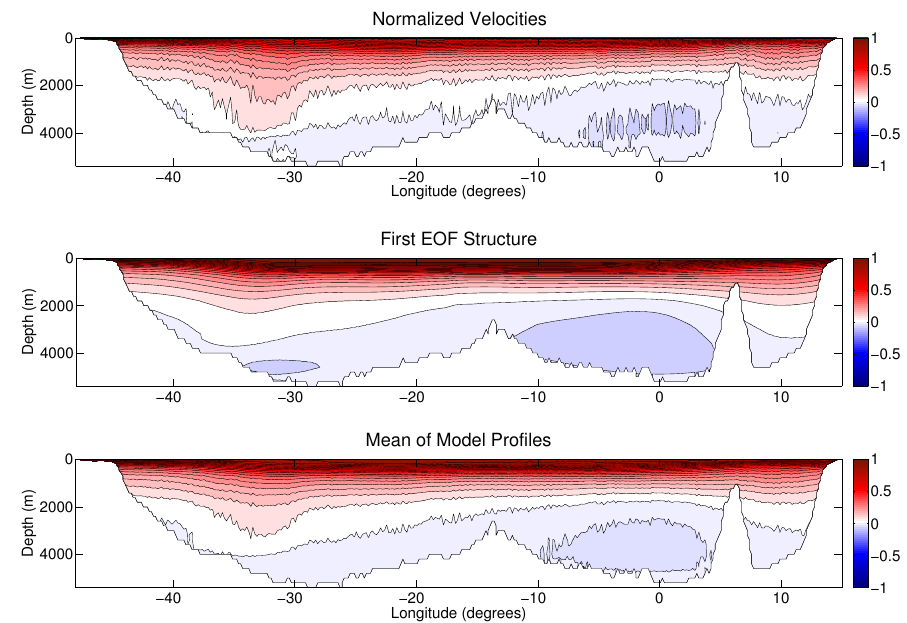
Fig. 5. Longitudinal sections showing the model profiles. (a) The normalized velocity method, (b) the EOF method, and (c) the mean of (a) and (b) i.e. the mean model section. Contour interval is 0.05.